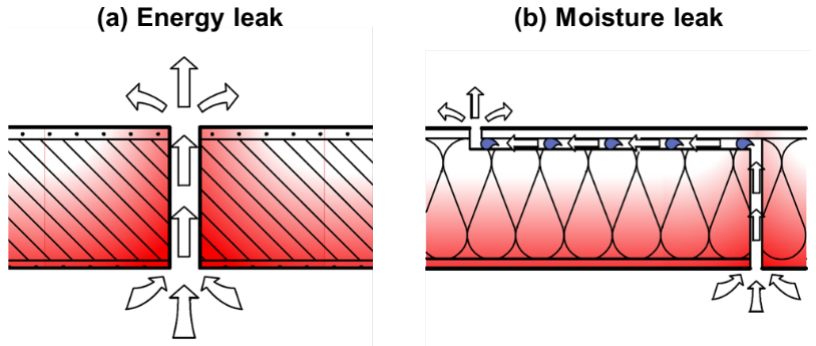
Figure 3. Types of indoor air leaks through joints or connections.